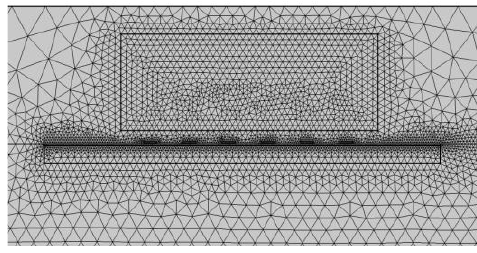
Figure 8. Meshing size of different domains after refinement.